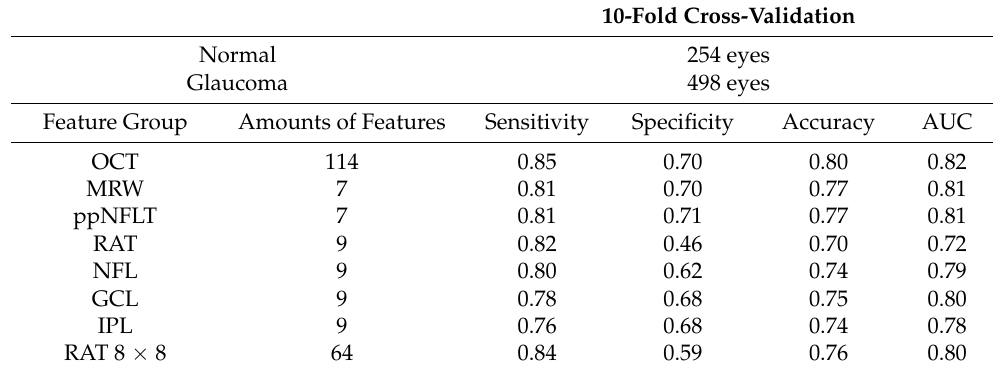
Table 3. Optical coherence tomography (OCT)-related feature groups, as well as the support vector machine (SVM) classification